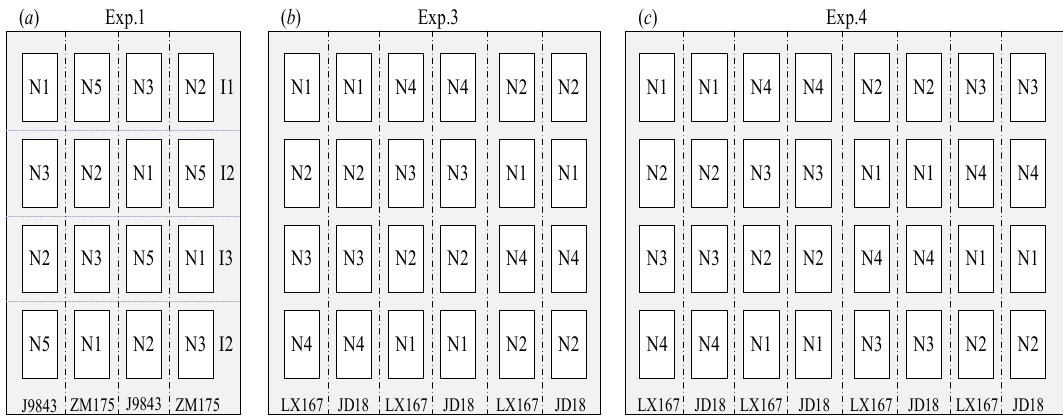
Figure 2. Plots experiments of cultivar, nitrogen and irrigation were designed in Xiaotangshan farm: ( a ) Exp.1; ( b ) Exp.3; ( c ) Exp.4. N1, N2, N3, N4, and N5 indicating five nitrogen fertilizer gradients of 0, 90, 180, 270, and 360 kg/hm 2 , respectively. I1, I2, and I3 indicating irrigation gradients of 0, 146, and 292 mm, respectively.